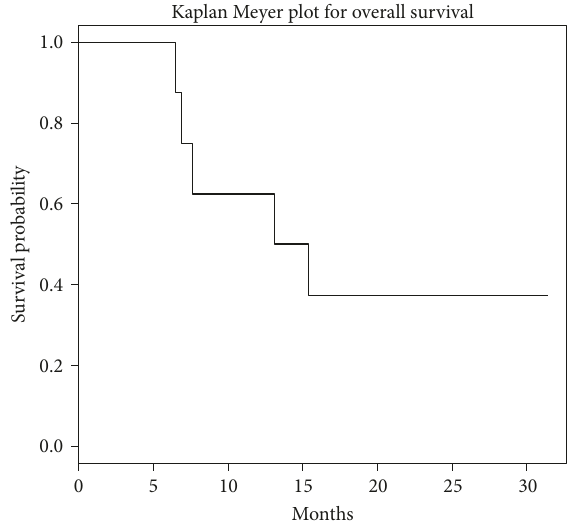
Figure 4: Median overall survival for the entire cohort. Median overall survival for this cohort was 14.2